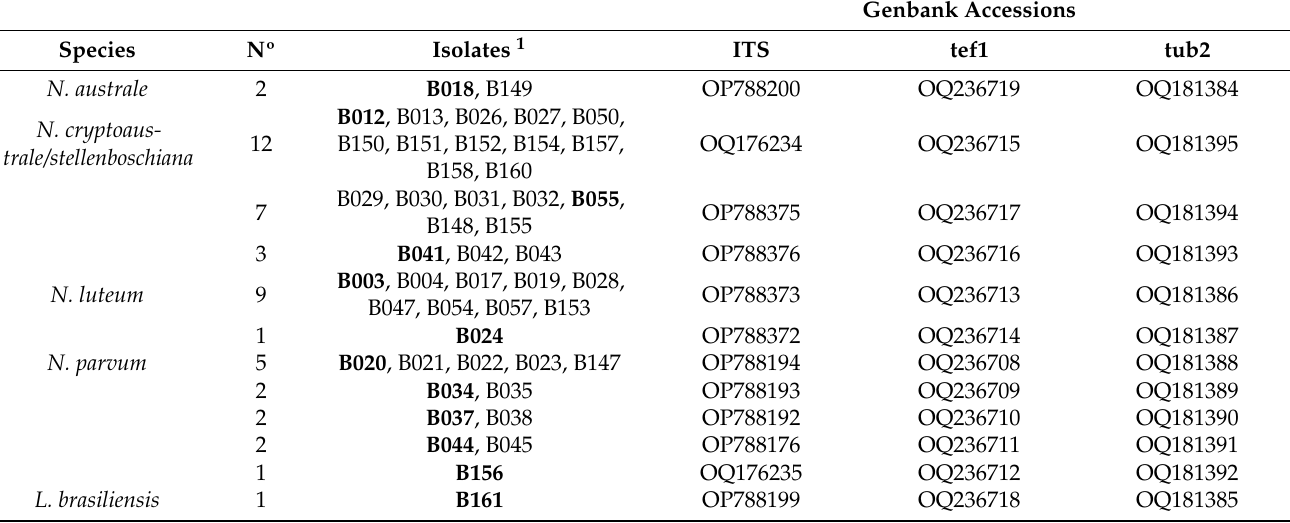
Table 2. GenBank accessions, representative isolates and groups of isolates with same sequences of Neofusicoccum and Lasiodiplodia species treated in the